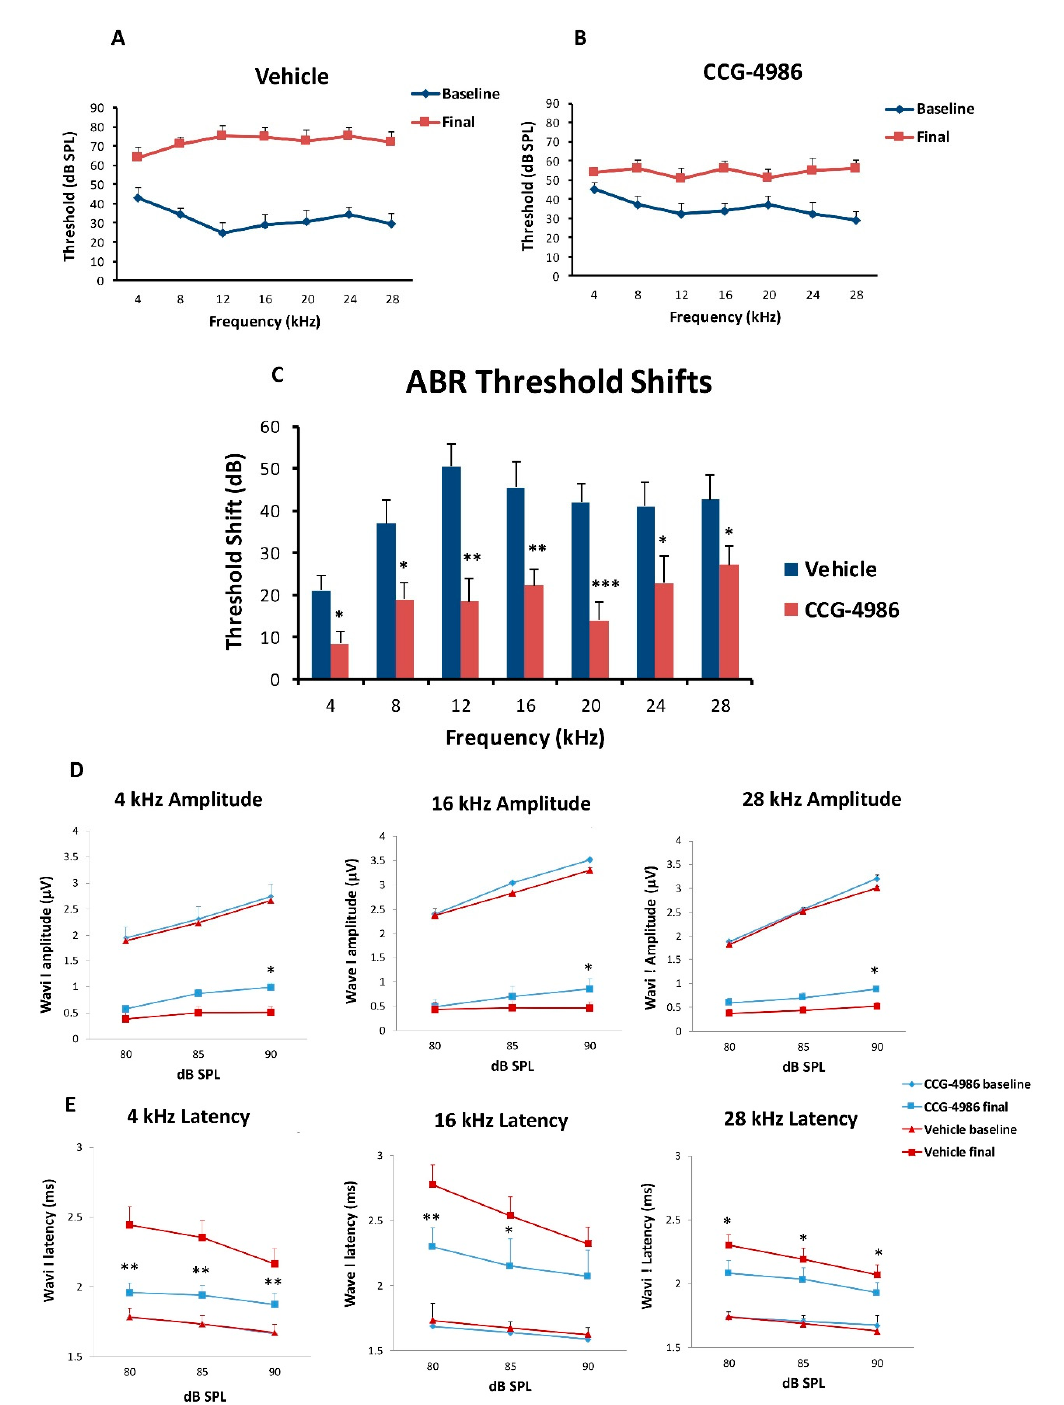
Figure 7. Baseline and final ABR thresholds for 4–28 kHz tone pips in animals exposed to octave band noise (8–16 kHz, 110 dB SPL) for 2 h and non-exposed animals. ( A ) Noise-exposed vehicle-treated animals, ( B ) Animals treated with CCG-4986 (100 μ M) 24 h post-exposure. ( C ) Comparison of permanent threshold shifts 15 days after exposure in drug- and vehicle-treated animals. Average baseline and final ABR wave I amplitudes ( D ) and latencies ( E ) at suprathreshold intensities in noise-exposed animals treated with CCG-4986 (100 µ M) or drug vehicle solution 24 h after noise exposure. Data presented as mean ± SEM. Vehicle control, n = 10; CCG-4986, n = 9. * p < 0.05 ** p < 0.01; *** p < 0.001. Two-way ANOVA followed by Holm–Sidak post-hoc test (ABR thresholds), Multivariate ANOVA followed by planned contrast comparisons (ABR suprathreshold